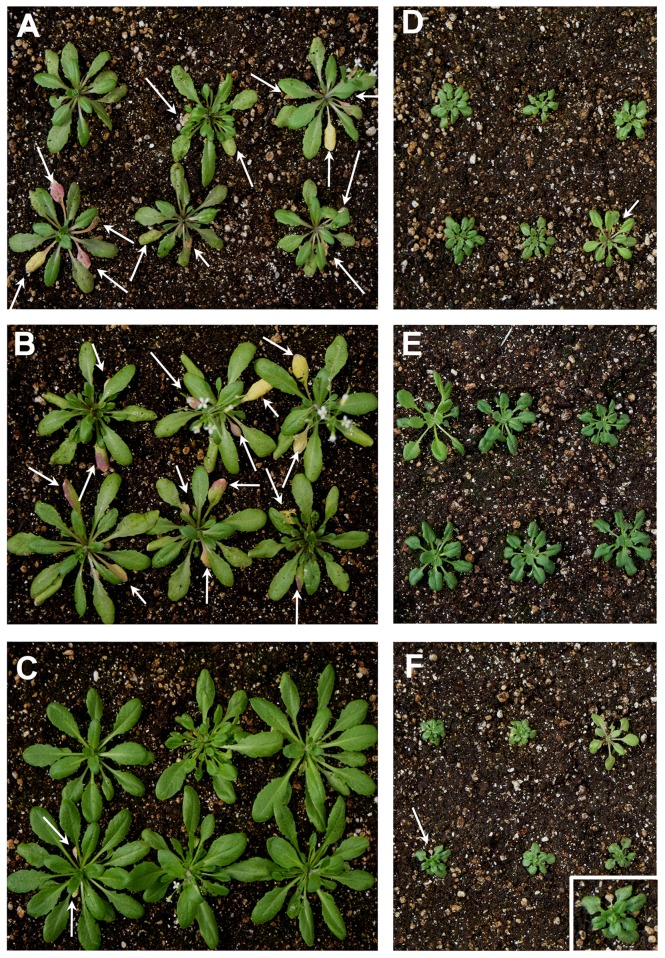

NF-YA overexpression produces a flooding tolerant phenotype.(A) to (F) represent plants belonging to WT, P35S:miR169nm and P35S:NF-YA3, 7, 10, 2, respectively, after 14 days of recovery. Arrows indicate senescent leaves. Inset in (F) is a magnification of P35S:NF-YA2 rosette. Two-week-old plants of each transgenic line were completely submerged in water-filled tanks in standard light/dark cycle (16/8) for 5 days and photographed after a recovery period of 14 days. The depth of the water column during submergence was kept at 6 cm above the pot surface.